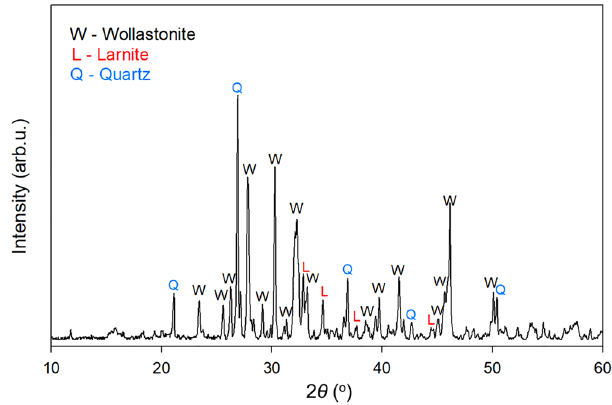
Figure 2. Representative X-ray diffraction (XRD) pattern of the employed calcium